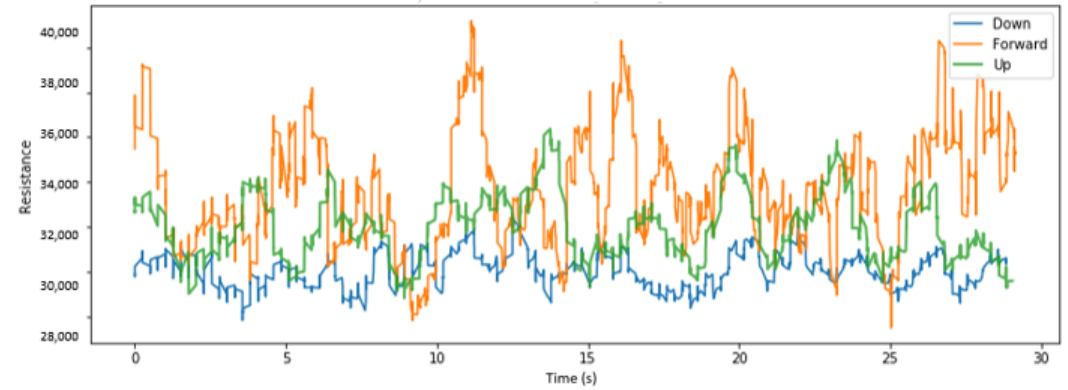
Figure 5. With center placement of short sensor, head tilt filtered data.